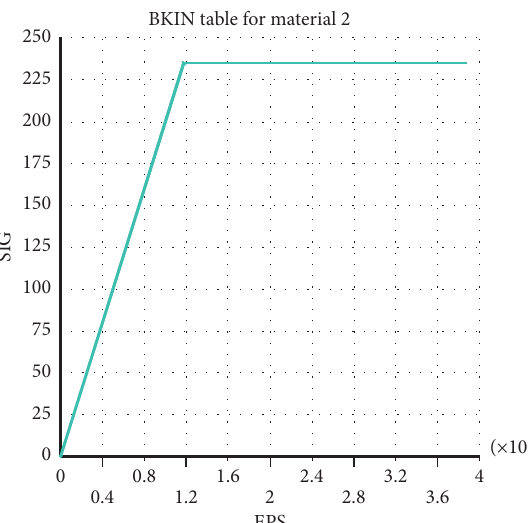
Figure 18: Constitutive model of steel tube.